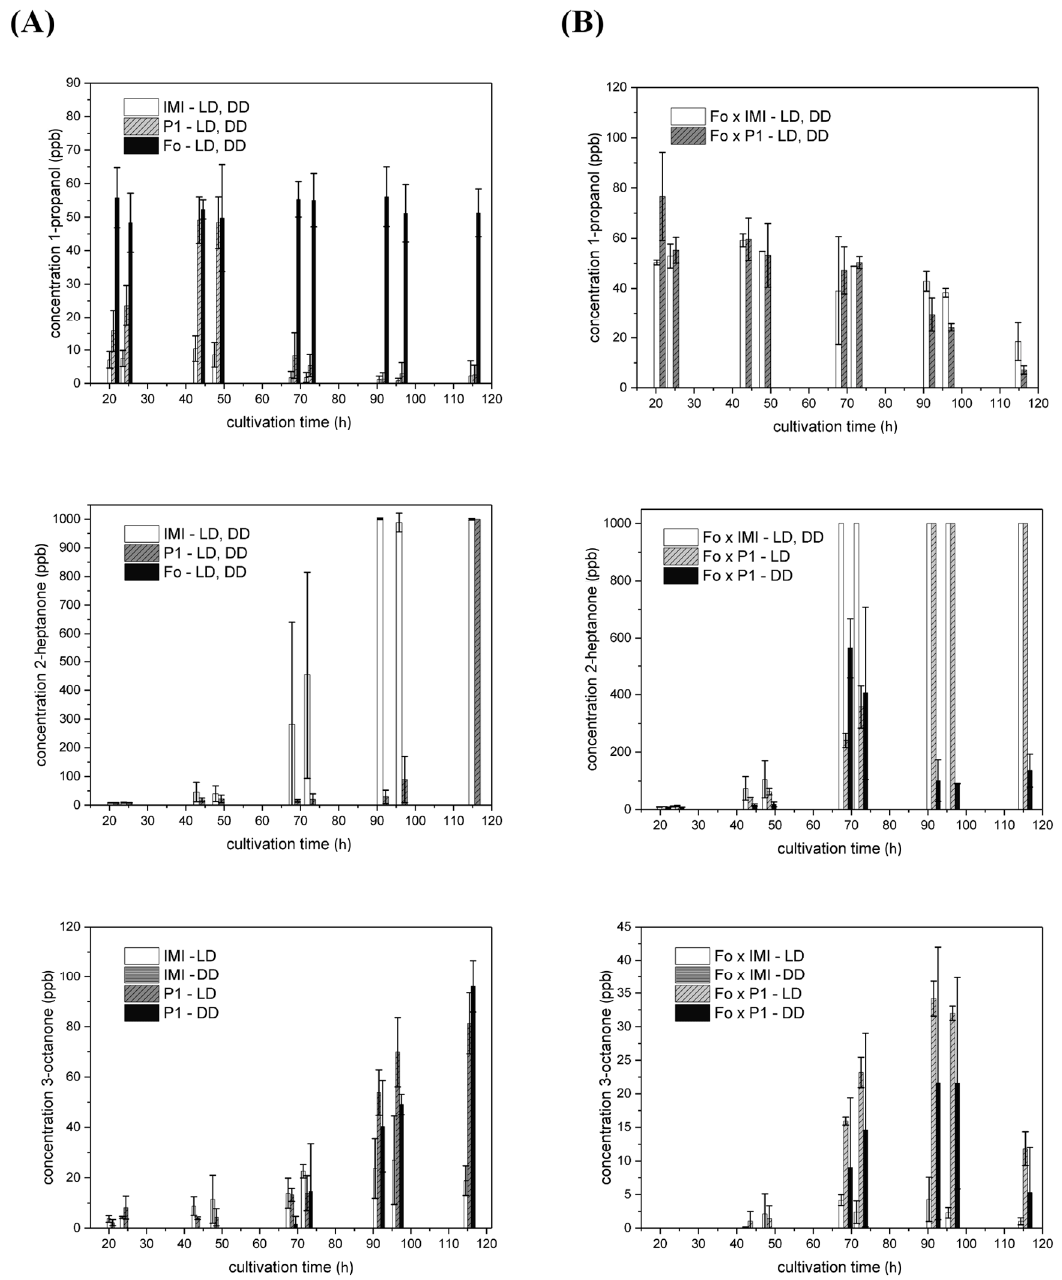
Figure 8. VOC production by T. atroviride P1 and IMI 206,040 upon interaction with F. oxysporum . Levels (ppb) of 1-propanol (row 1), 2-heptanone (row 2), and 3-octanone (row 3) detected in the headspace of ( A ) axenic cultures of T. atroviride P1 (P1), T. atroviride IMI 206040 (IMI), or F. oxysporum (Fo) or of ( B ) co-cultures of T. atroviride P1 or IMI 206040 with F. oxysporum (Fo × P1; Fo × IMI) on PDA in Schott bottles at 25 ◦ C. Cultures were incubated either under light-dark conditions (LD) or in complete darkness (DD) as indicated. GC–IMS measurements were conducted along a cultivation period of 120 h. Results shown are means ± SD ( n ≥